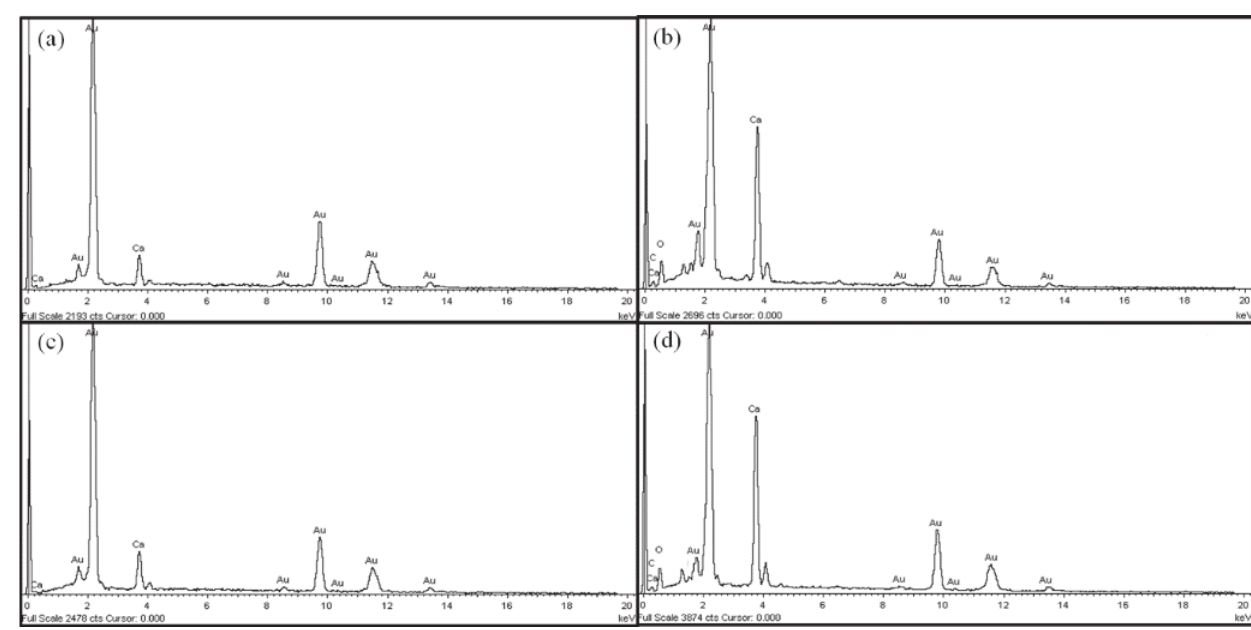
pressive strength statistically increased in the mortar specimens